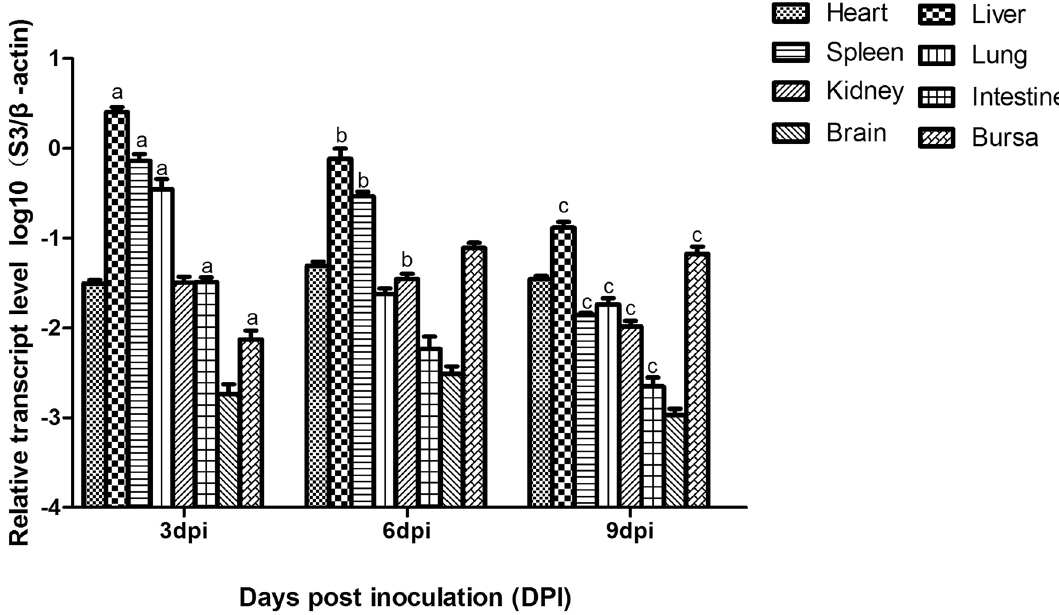
Figure 7. Viral loads in different tissues of chickens infected with NDRV by the s.c. route. The relative expression of viral RNA in tissues was determined by SYBR Green I real-time PCR assay (S3 gene as a target gene and chicken β-actin gene as a reference gene). Each sample was tested in triplicate. Error bars were expressed as standard deviation of the means (n = 3). Data are expressed as the mean log10 (E/β-actin) ± SD. Different lowercase letters over the bars showed statistically significant differences (P < 0.05) between different days after infection. The data were calculated by the one-way analysis of variance with Tukey’s post-test. (a) 3 dpi